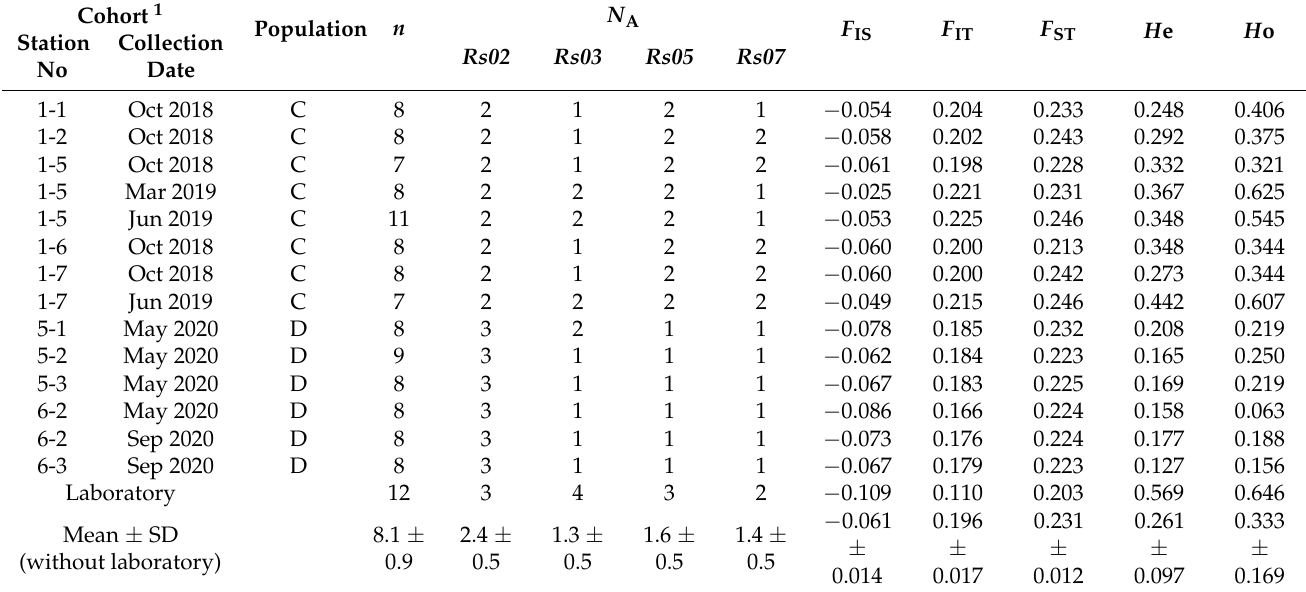
Table 2. Statistics of microsatellite loci and F -statistics for Reticulitermes speratus cohorts collected in Isogi Park from